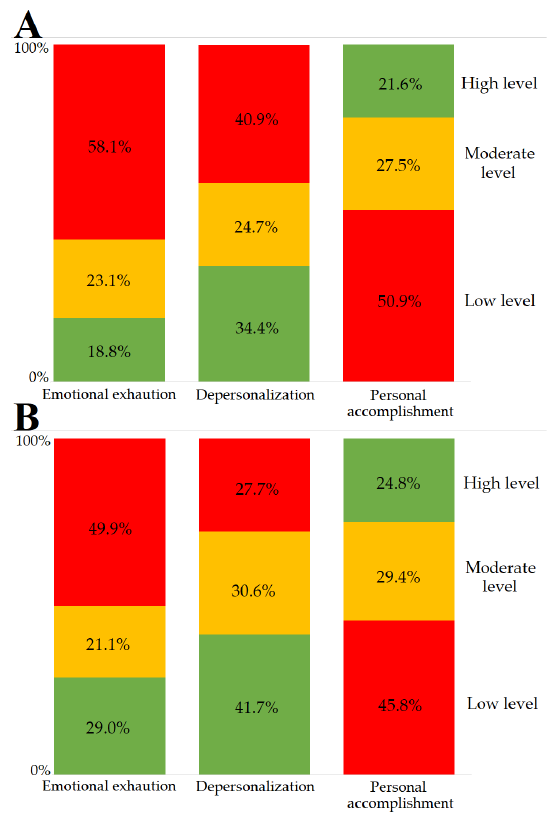
Figure 2. Comparison of the distribution of burnout levels in all dimensions in healthcare workers with the experience of the work at COVID-19 units ( A ) and those without the experience ( B ) (burnout depicted in red according to the above Data Analysis section).